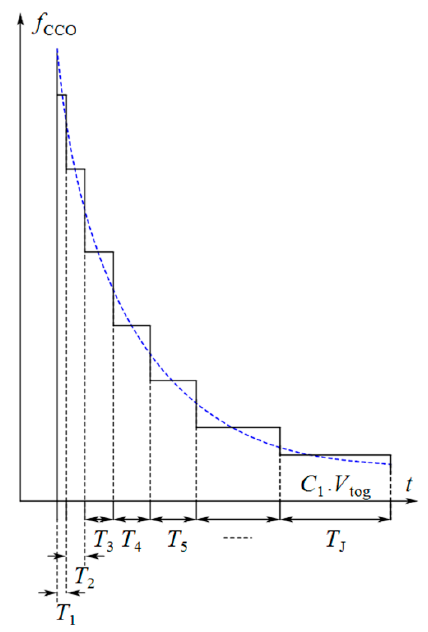
Figure 9. Frequency of the output pulses of the CCO and its envelope (by exaggeration in the sizes of the unit blocks).